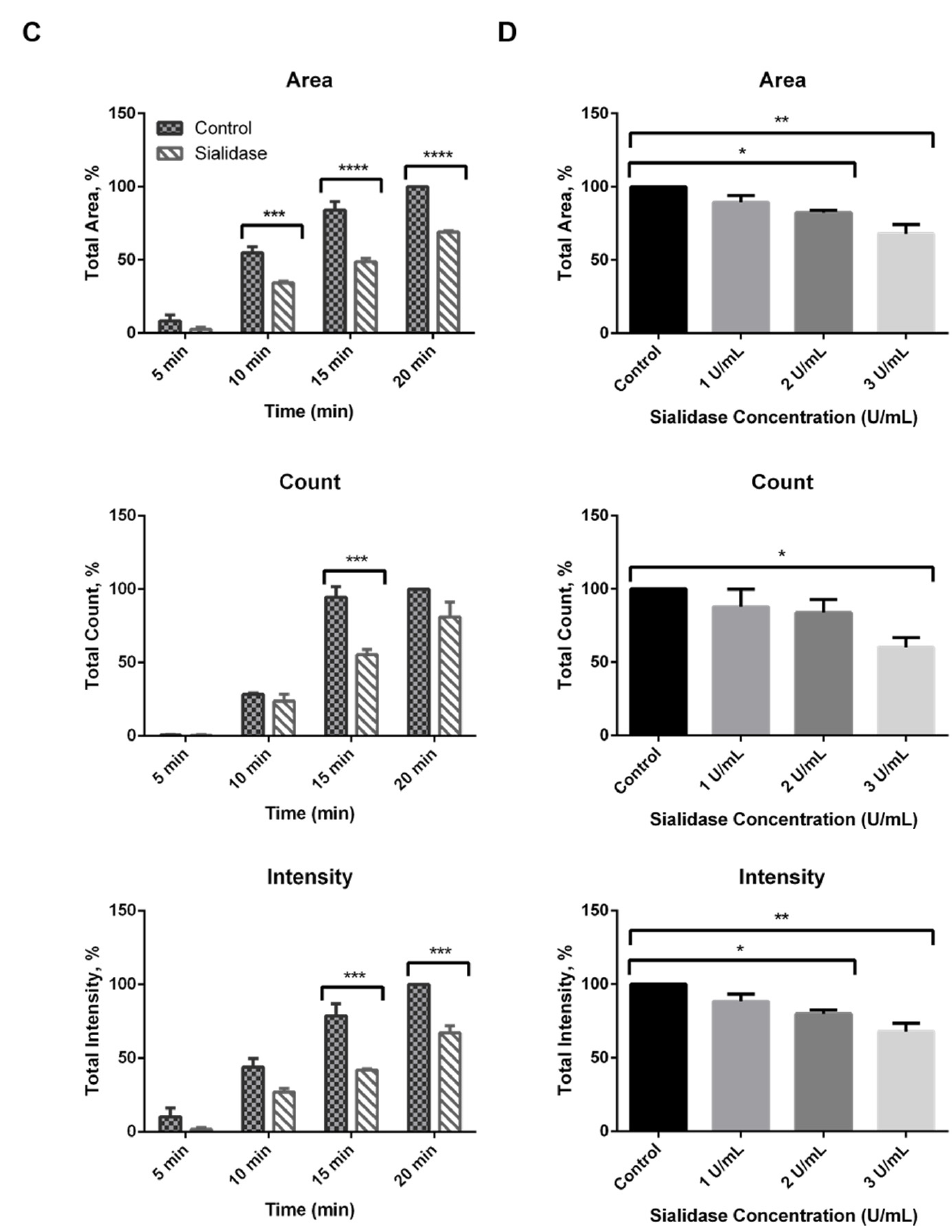
Figure 5. Effects of desialylation on EGF-induced internalization of EGFR-GFP clusters in EGFP-KI cells. ( A ) Time-lapse fluorescence images of EGFP-KI cells treated with 100 ng/mL EGF-Alexa Fluor 555 for 5–20 min at 37 °C; ( B ) EGFP-KI cells pretreated with sialidase (3 U/mL for 1 h) followed by 100 ng/mL EGF-Alexa Fluor 555. Scale bar, 5 µm; ( C ) Time-dependent high content analysis of normalized total fluorescence intensity, count and area of EGFR clusters per cell; values are reported as the means ± SEM of three independent experiments; ( D ) Dose-dependency of EGF-induced EGFR-GFP internalization on sialidase; values are reported as the means ± SEM of three independent experiments. Each value was normalized to the highest value for comparison purposes. p values were calculated using two-way ANOVA with * p ≤ 0.05, ** p ≤ 0.01 *** p ≤ 0.001, and **** p ≤ 0.0001 considered significant.